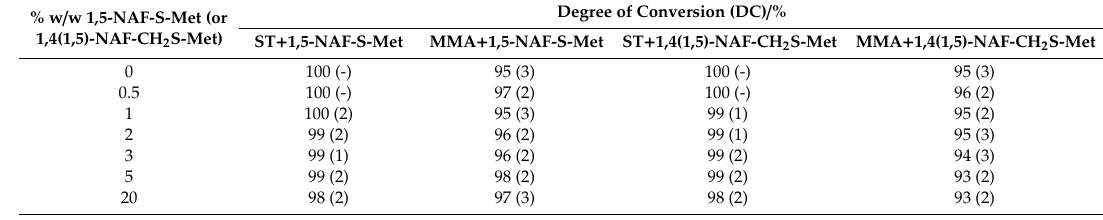
Table 3. Degree of conversion (%) of studied polymers.